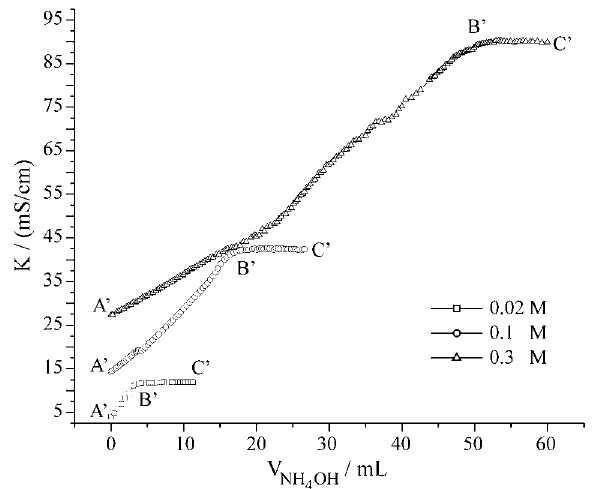
Figure 3. Curvas conductimétricas para diferentes concentraciones de Al 2 (SO 4 ) 3 tración 0.3M aproximadamente entre 23 mL y 39 mL.